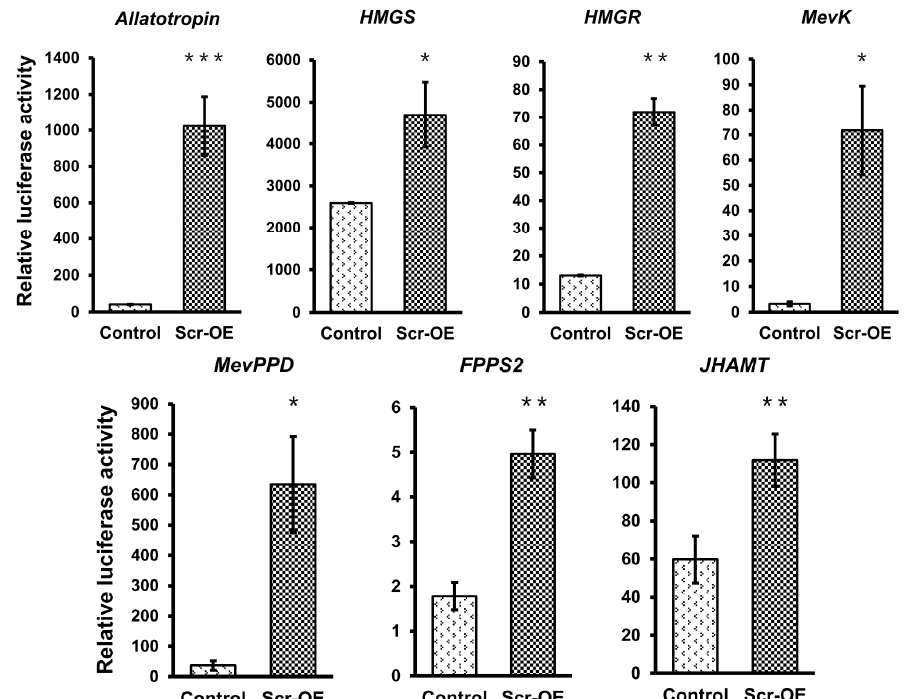
Figure 7. The effects of Scr overexpression on the activities of the promoters of genes involved in JH biosynthesis. Luciferase reporter analysis in BmE cells indicated that the activities of the promoters of